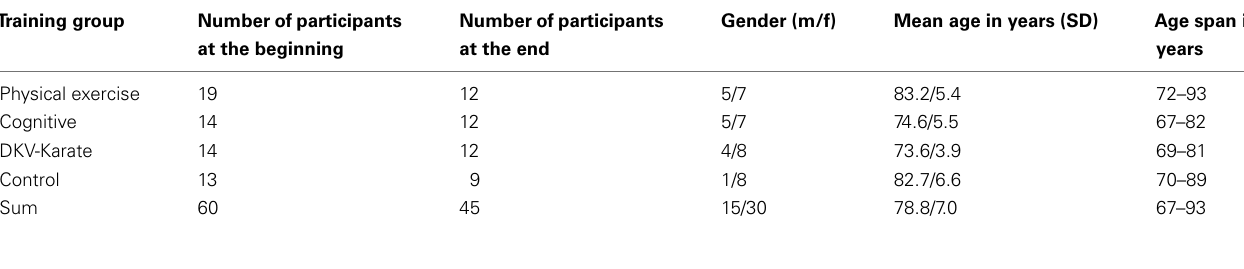
Table 1 | Number of participants, gender distribution, and mean age for the four different training groups. Training